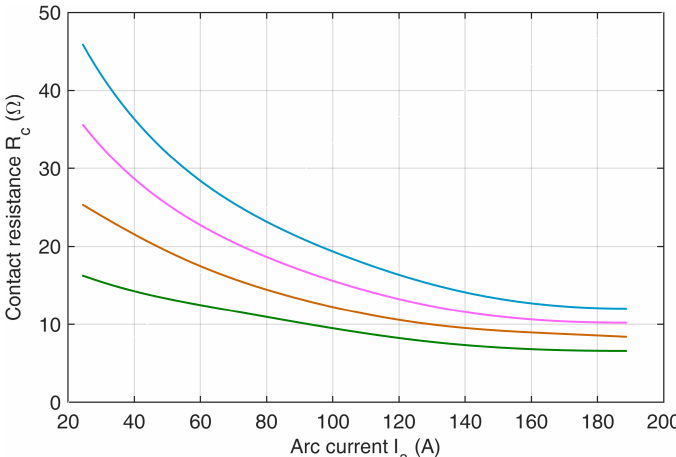
Figure 4. Static contact resistance vs. arc current I a for various contact force F m values: blue (about 20N), pink (about 30N to 50N), light brown (about 50N to 80N), green (about 80N to